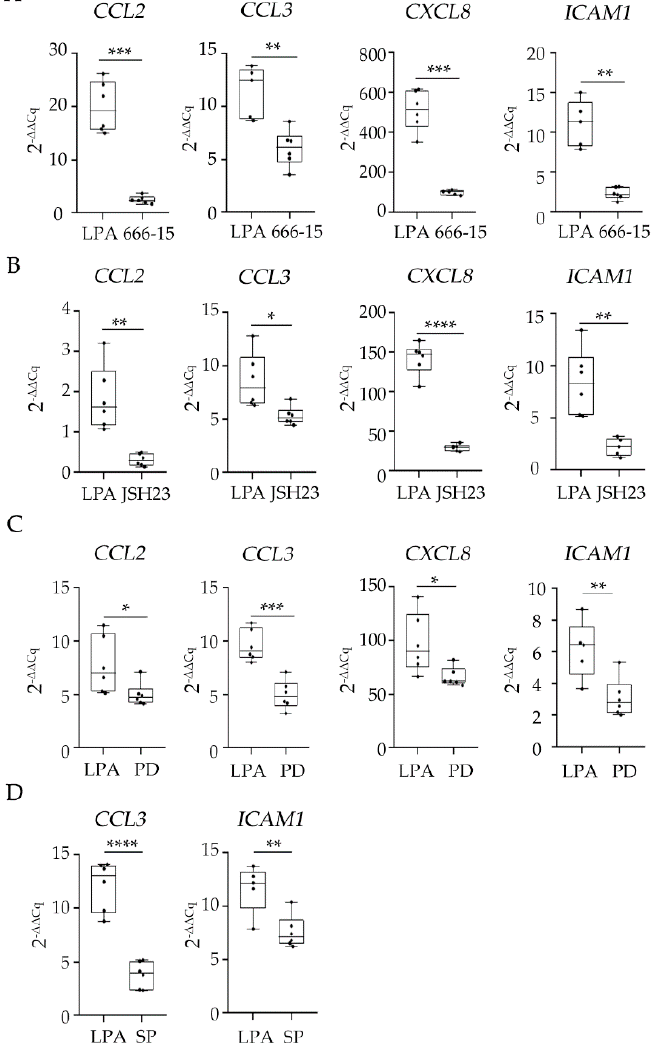
Figure 8. Pharmacologic dissection of LPA-induced cellular signaling pathways. HKC-8 cells were pretreated for 1 h with 666-15 (CREB1 inhibitor) 10 µ M in ( A ), JSH23 (NF κ B inhibitor) 100 µ M in ( B ), PD98059 (MEK/ERK inhibitor) 50 µ M in ( C ), or SP600125 (JNK inhibitor) 50 µ M in ( D ) and then activated with LPA at a final concentration of 10 µ M for 4 h. mRNA-expression levels of the indicated secreted factors were quantified with RT-qPCR. The Cq values of each gene were normalized against the Cq values of B2M. Statistical analysis was performed with unpaired t -test or Welch’s test in the case of normal data and with Mann–Whitney in the case of non-normal data. * p < 0.05, ** p < 0.01, *** p < 0.001, **** p < 0.0001. See also Figure